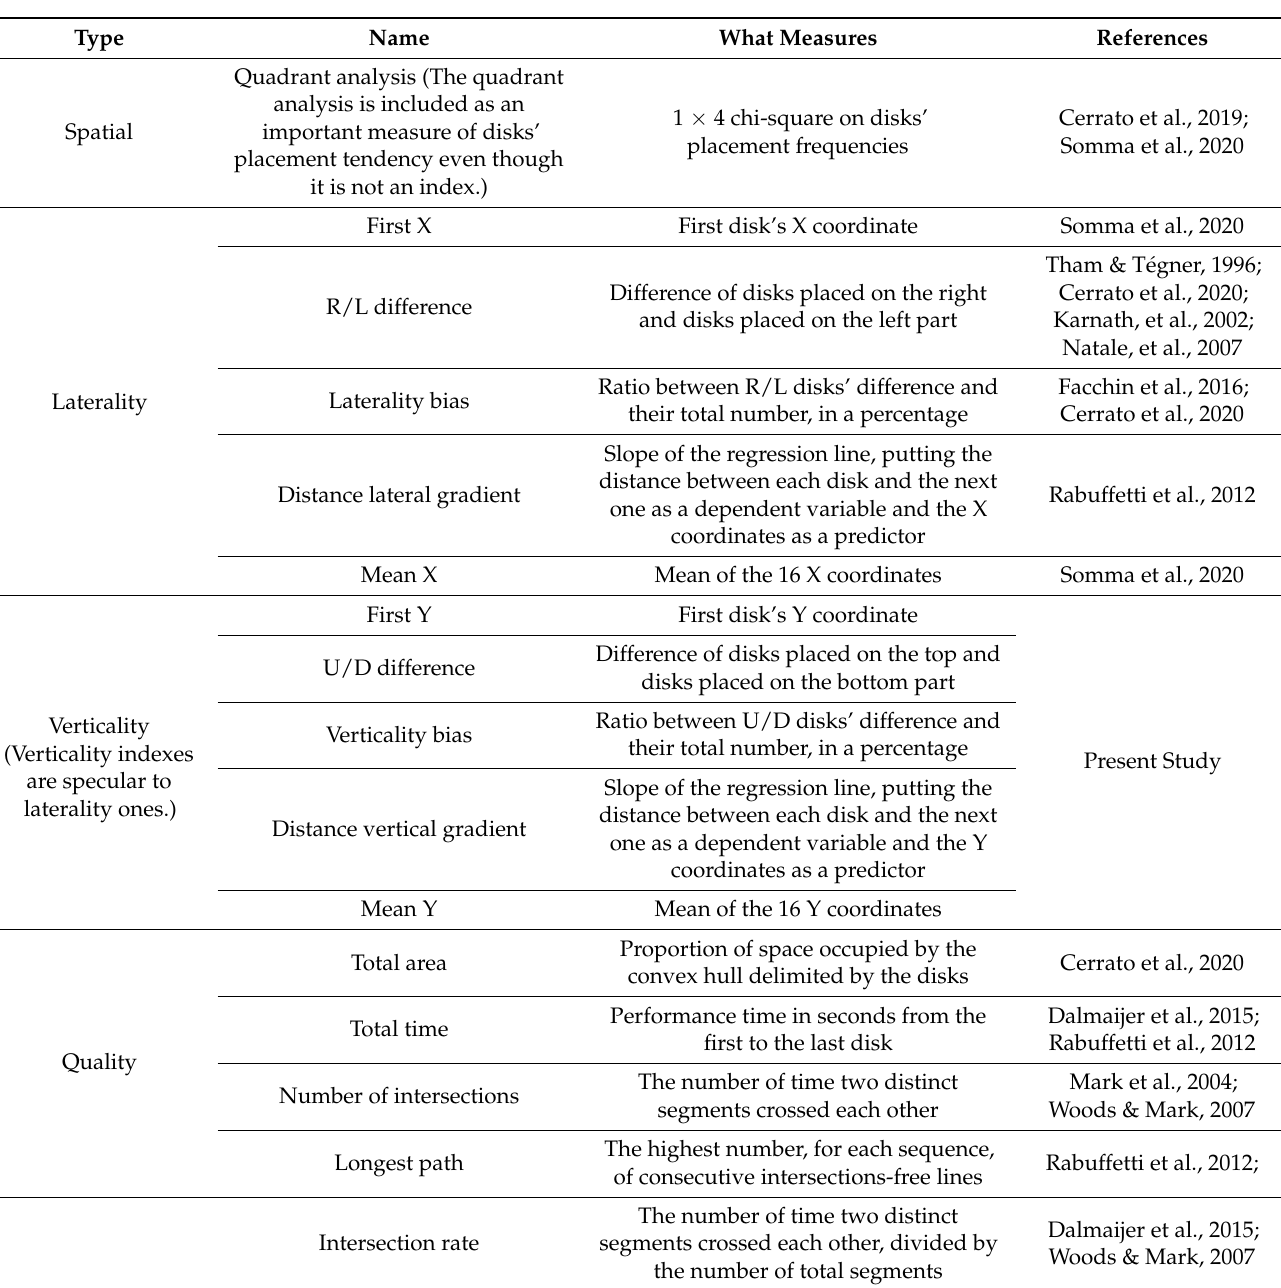
Table 1. List of all the